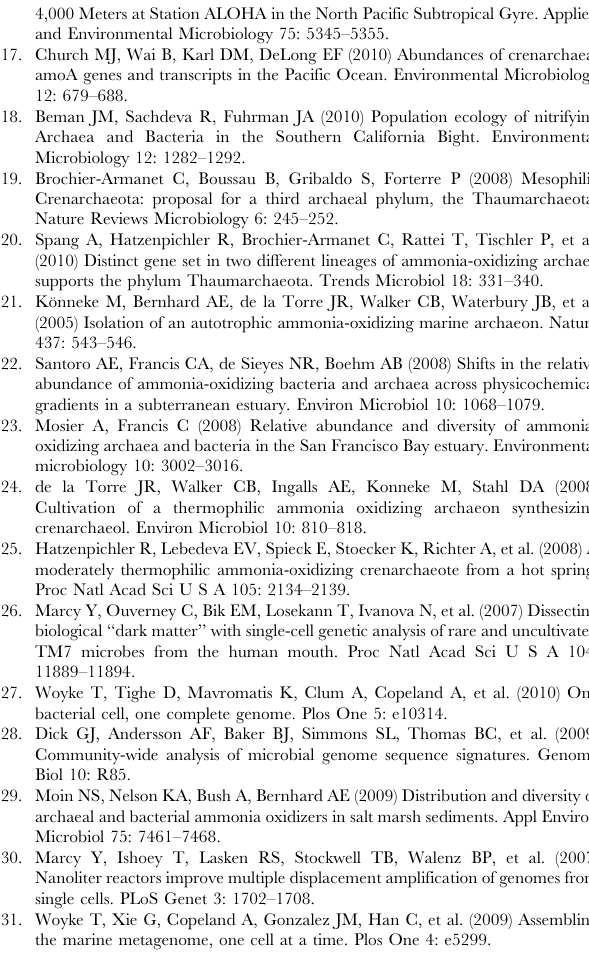
Movie S1 Movie shows last stage of sorting cell 90507.21 (occurring in the area on the device beyond the second gate valve). The laser trap is fixed near the end of the fiducial arrow. In the movie, the cell is moved some 10 s of micron before the stage is stopped. The trap beam is interrupted when the stage is